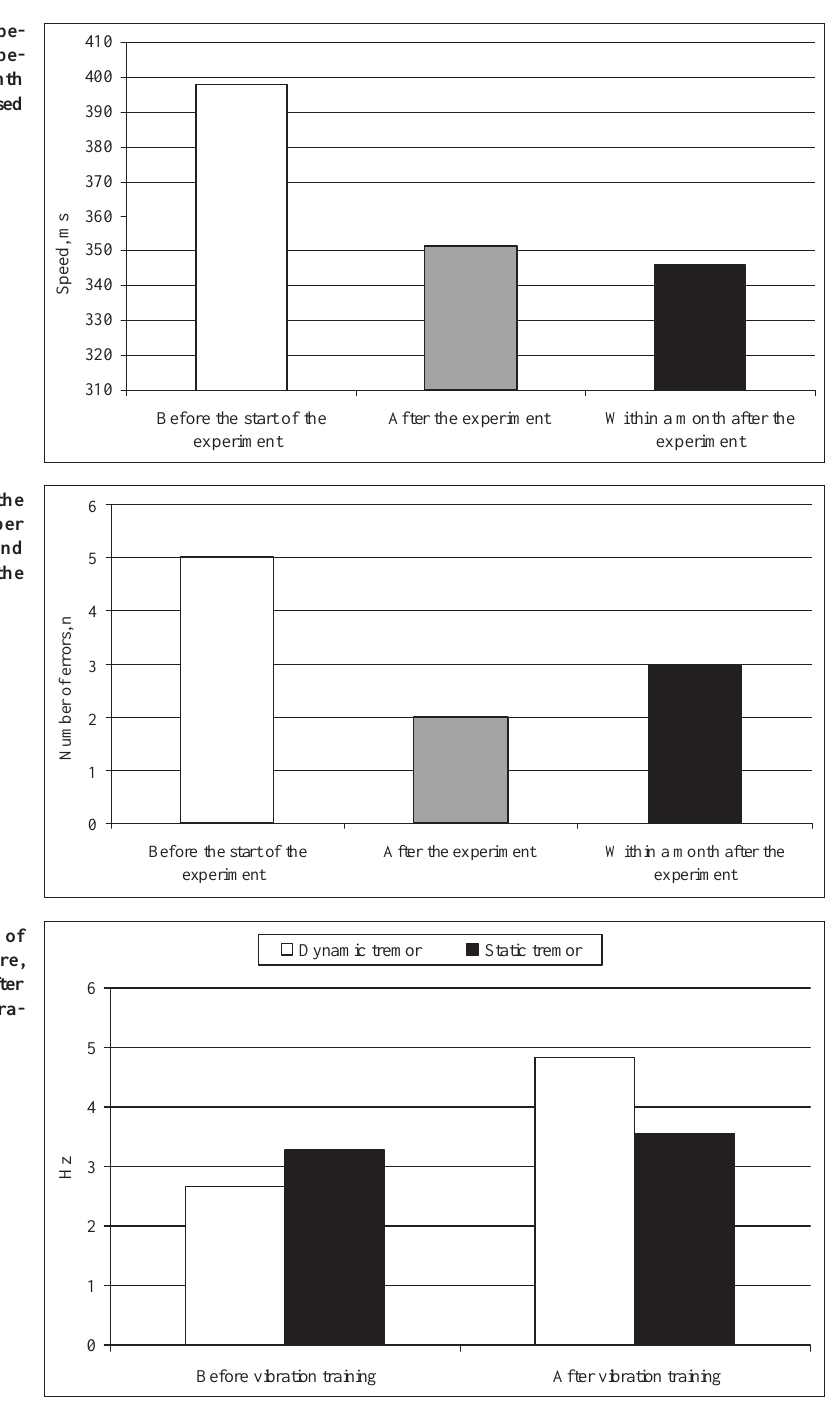
Figure 3. Dynamics of the indicators of spe- ed of the complex motor response (ms) be- fore, after experiment and within 1 month after completion of the program of dosed vibration training